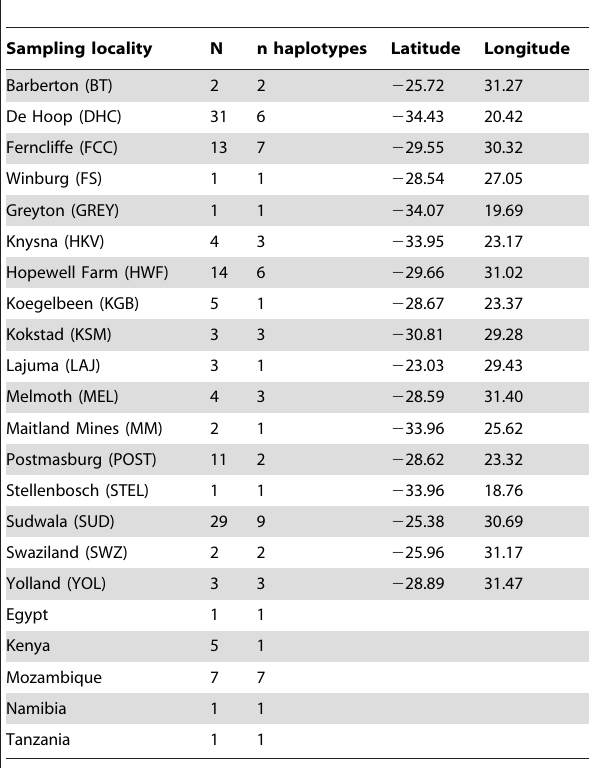
Table 1. The number of samples (N) and haplotypes (n haplotypes) for each sampling